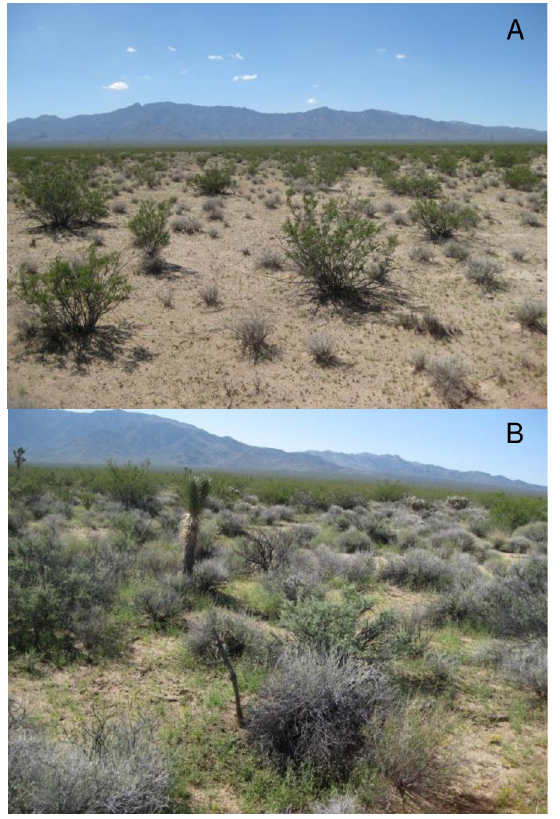
Fig 3. The species richness and ground cover by annual plants in Mojave National Preserve in August 2012. Annual species richness (A) and percent ground cover (B) in summer 2012 by site presented as means with 95% confidence intervals. Yucca woodland (YW) had greater species richness and ground cover by annuals per plot than did creosote scrub (CS; P < 0.001 in both cases).